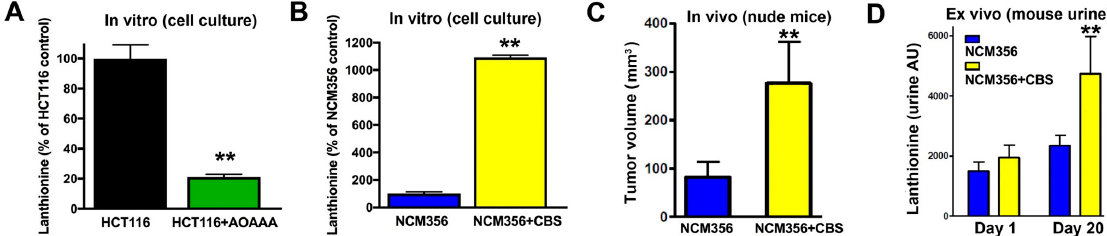
Figure 10. Lanthionine is a potential biomarker of CBS-expressing colon cancer cells. ( A ) Inhibition of CBS suppresses lanthionine production in HCT116 cells. ( B ) Forced overexpression of CBS increases lanthionine production in NCM356 cells. ( C ) Effect of CBS overexpression on NCM356 tumor volume 20 days after implantation. CBS-overexpressing NCM356 cells grow larger tumors than parental cells in nude mice. ( D ) Comparison of urine lanthionine levels NCM356 tumor-bearing mice 1 day and 20 days after tumor cell implantation (n = 5, ** p < 0.01).